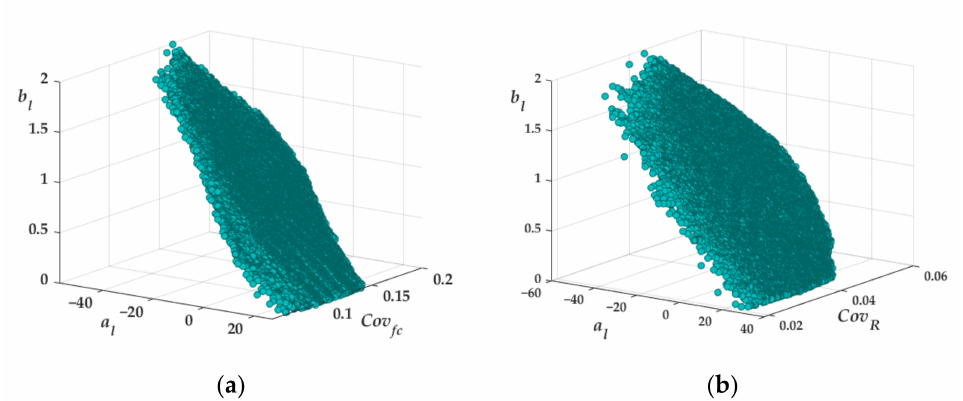
Figure 2. Calibration of the empirical model based on the data acquired in m = 15 points of the investigated structure: ( a ) Plot of the coefficients of the calibrated linear empirical laws and of the coefficient of variation of the concrete strength; ( b ) Plot of the coefficients of the calibrated linear empirical laws and of the coefficient of variation of the rebound